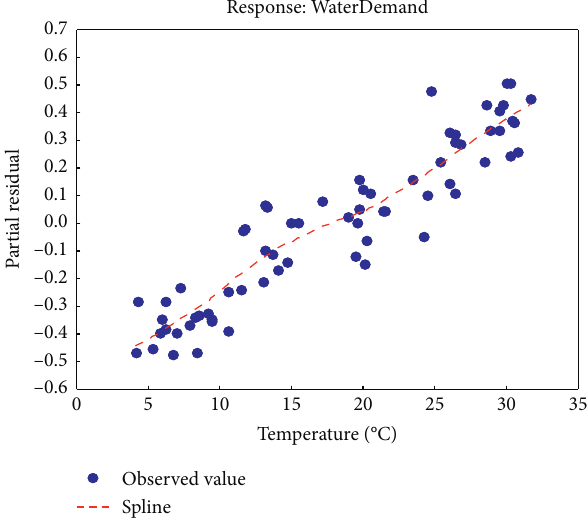
Figure 4: The combined response of the water consumption to